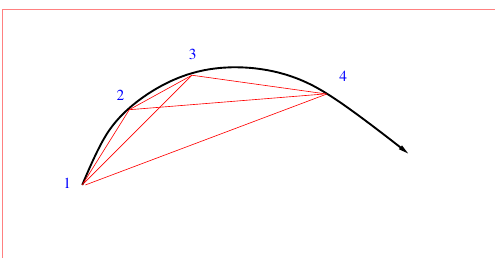
= f [ C )] = f [ f ( C , f ( C , C 41 43 32 21